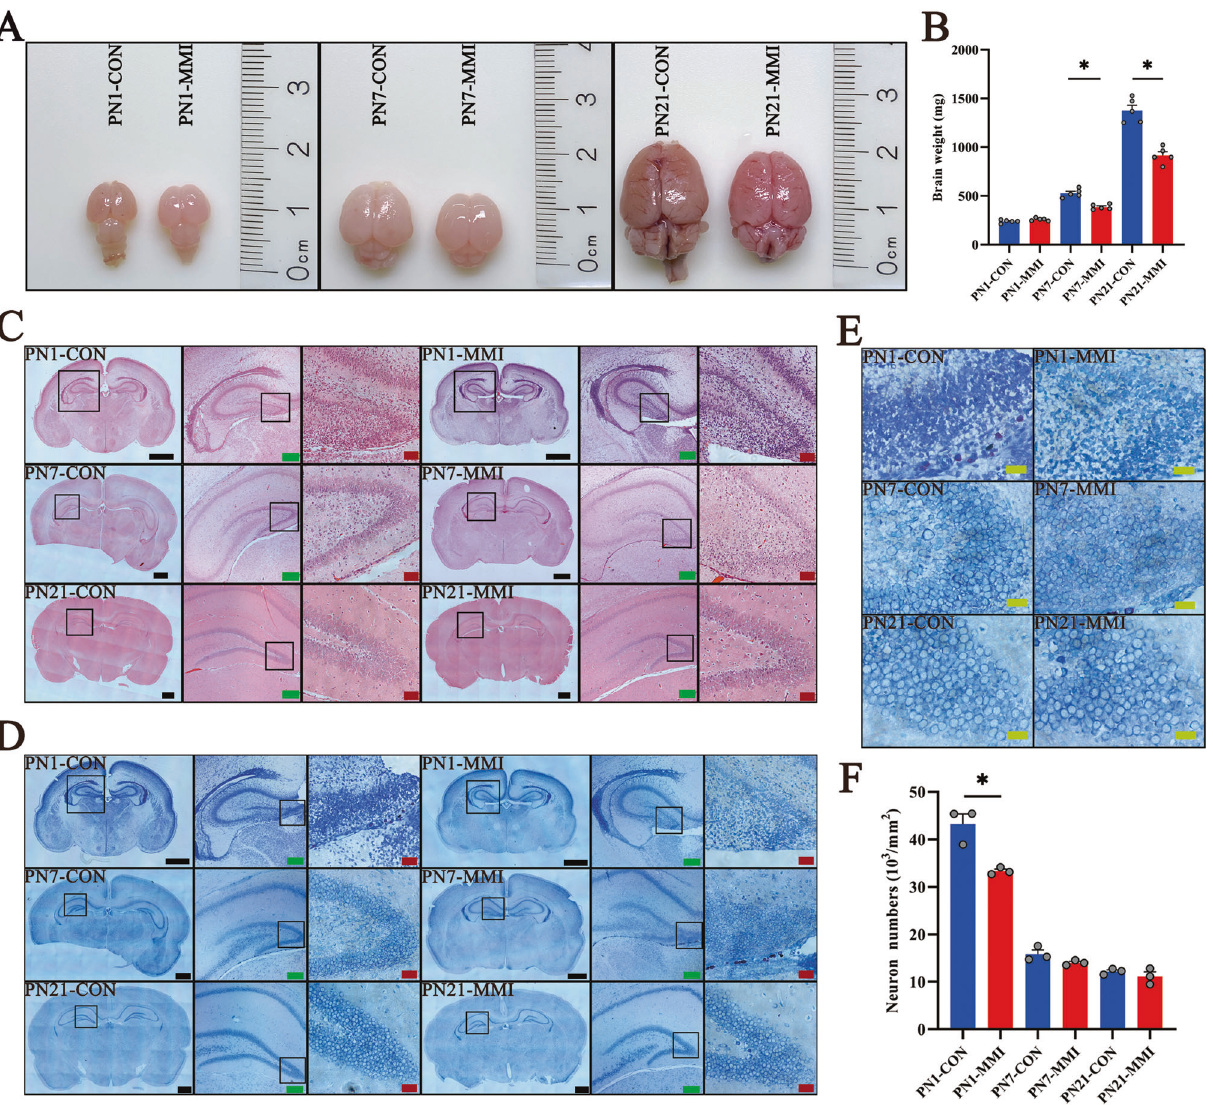
Fig. 1 Comparison of cerebral histomorphology between rats with or without CH. A , B The volume and weight of brain tissue of rat pups with or without CH, n = 5. C HE staining of the morphology of the hippocampus in the control and CH group. D – F Nissl ’ s staining of the hippocampal morphology and the number of neurons in the dentate gyrus of rat pups. The rectangle indicates the magni fi ed region. Statistical analysis of neuron number in triplicates every 15 fi elds. Scale bars: black, 1000 μ m; green, 200 μ m; red, 50 μ m; yellow, 20 μ m. Error bars represent the standard error (* P <